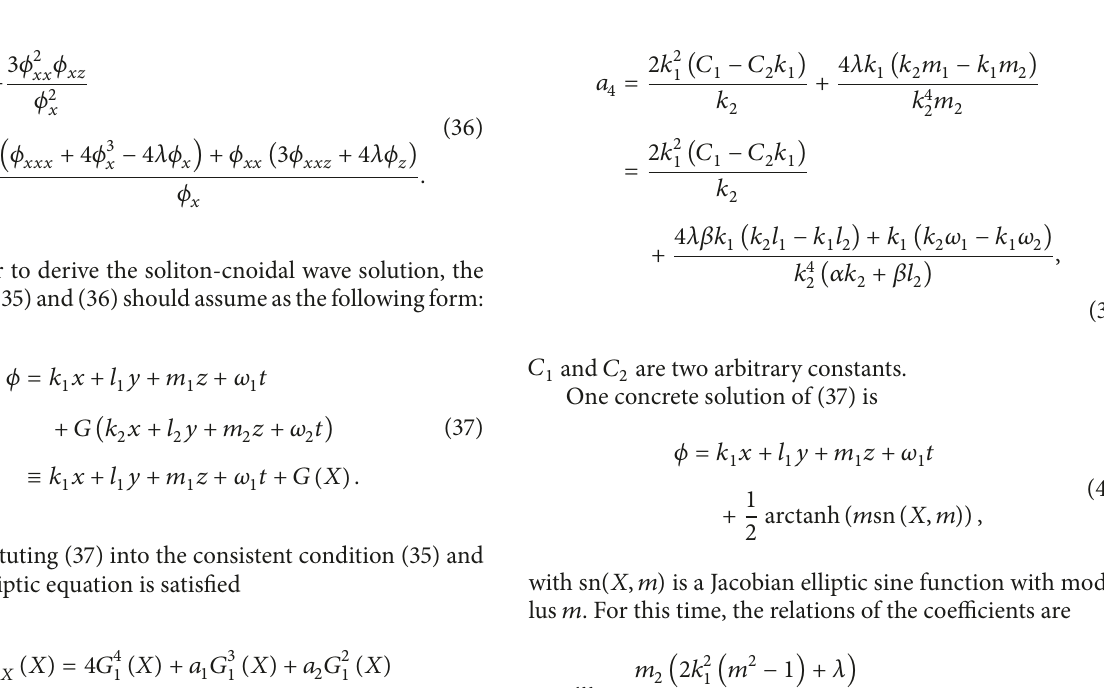
1 , but 𝑙 = −𝑙 = 1/2, 𝑘 = −𝑙 = 3/2, 𝑘 = 2 1 3 2 2 3